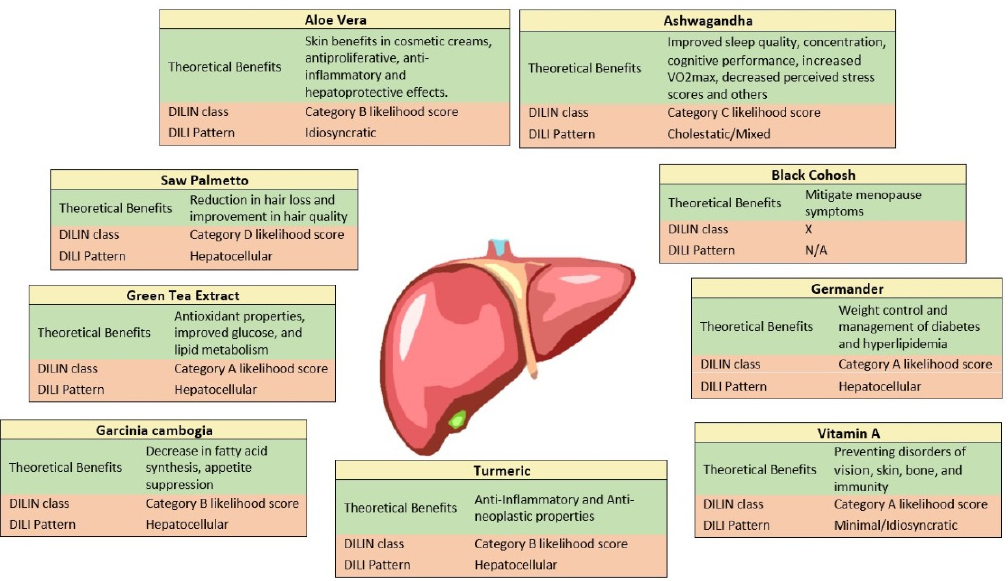
Figure 1. Summary of 9 common hepatotoxic HDSs on the market with their theoretical benefits; DILIN class, i.e., likelihood of causing clinically significant liver injury; and the pattern of resultant liver injury. Likelihood score obtained from the DILI Network LiverTox database [19,39,74,100,103]. It is a 5-point scale (A to E) that estimates whether a medication is a cause of liver injury: A = well-known cause; B = highly likely cause; C = probable cause; D = possible cause; E = unlikely cause; E* = suspected but unproven cause; X = unknown.